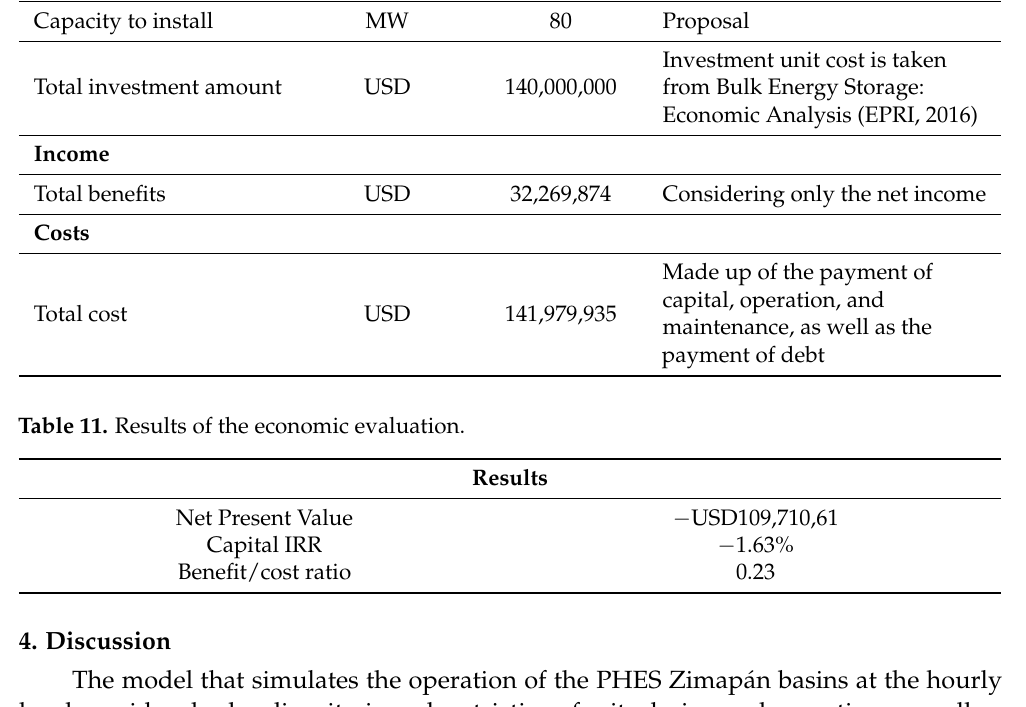
Figure 15. Behavior of the spilled volume in the upper tank throughout the simulation, 3 years. Own source with analysis of results.